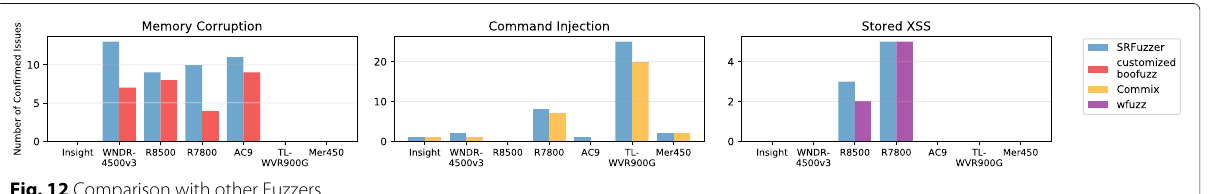
Fig. 12 Comparison with other